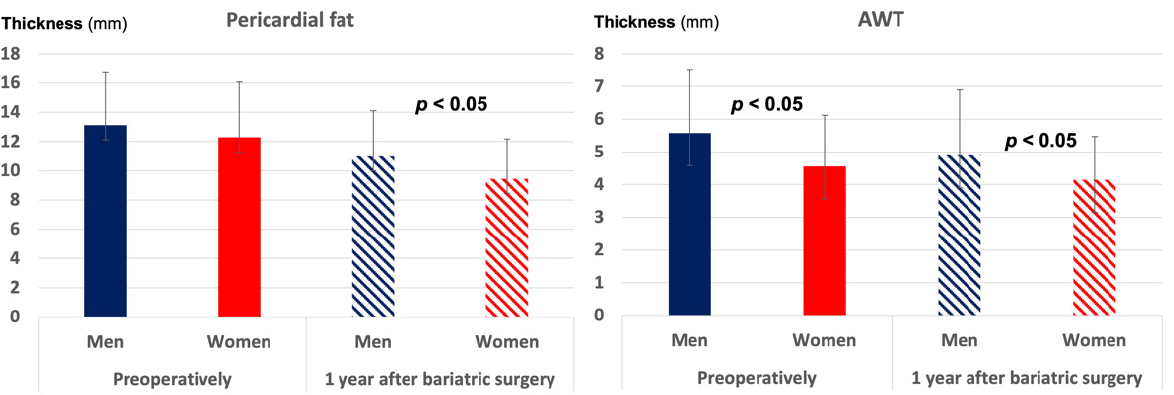
Figure 2. Pericardial fat thickness and AWT (in mm) in women and men preoperatively and 1 year after bariatric surgery. The bars indicate the mean values, and the error bars the standard deviations. p values of significance for comparison between men and women at each study visit.